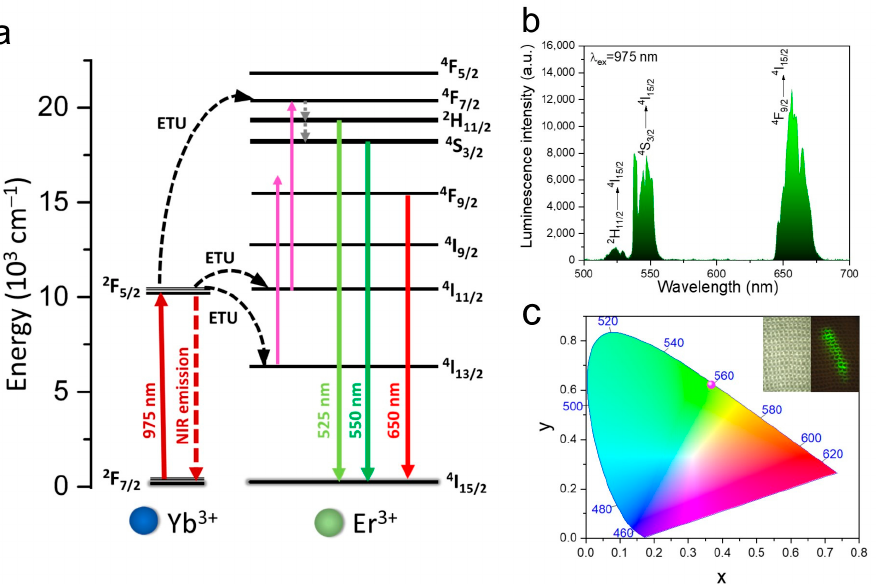
Figure 3. ( a ) Scheme of the energy level diagram of Yb 3+ and Er 3+ , showing possible upconversion processes in the YF 3 : Yb 3+ , Er 3+ system, ( b ) upconversion emission spectra of YF 3 -modified fibers, and ( c ) the corresponding chromaticity diagram; the inset shows photographs of a knitted fabric made of YF 3 -modified fibers in daylight (left) and under NIR ( λ ex = 975 nm) laser irradiation (right).